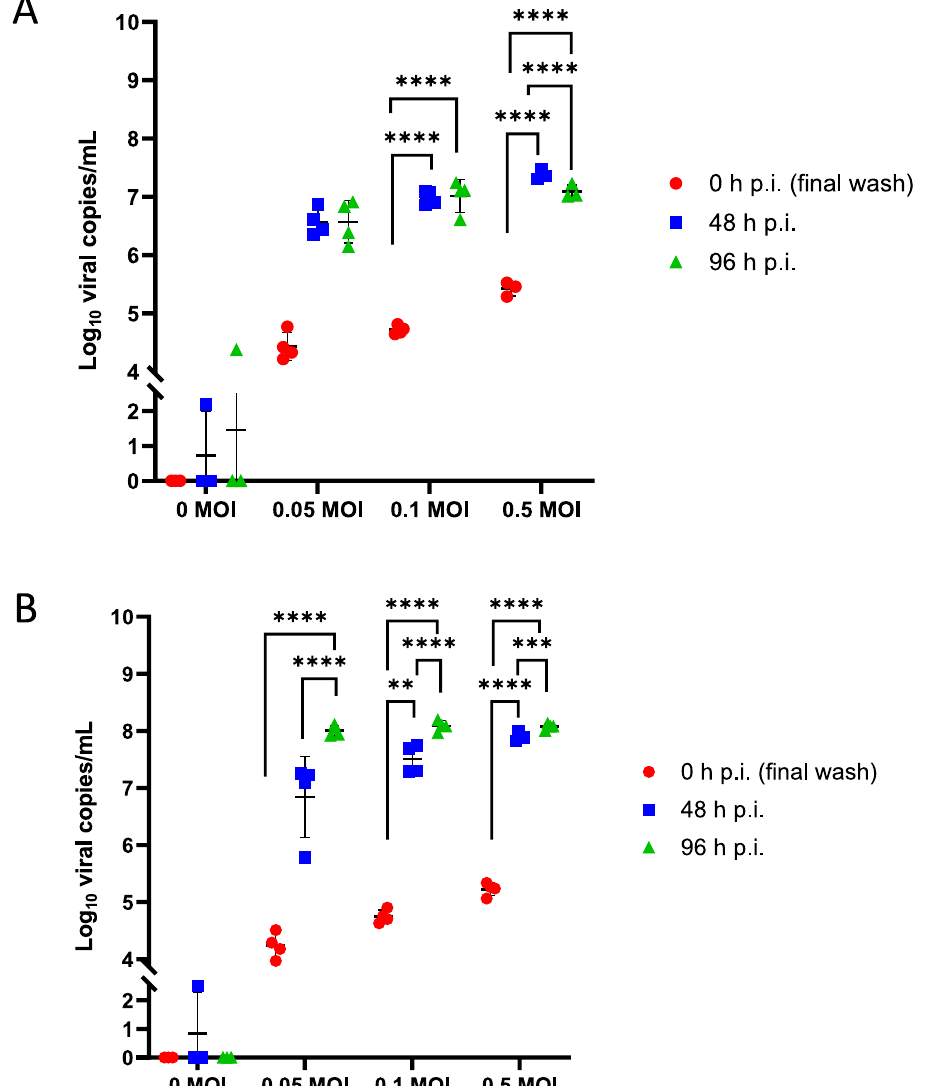
Figure 8. Infection kinetics of HCoV-NL63-inoculated PREDICT96-ALI airway tissue. RT-qPCR analyses for viral copies in the apical wash of PREDICT96-ALI airway tissue at 0, 48 and 96 h p.i. for two human donors showing unique infection kinetic profiles. ( A ) PREDICT96-ALI donor A airway tissue inoculated with HCoV-NL63 and monitored for an increase in viral load at 48 h intervals with a statistically significant increase in viral copies at 48 and 96 h p.i compared to 0 h p.i. for the MOI 0.1 and 0.5 conditions. Statistical significance: ****p ≤ 0.0001. ( B ) PREDICT96-ALI donor B airway tissue inoculated with HCoV-NL63 and monitored for an increase in viral load at 48 h intervals with a statistically significant increase in viral copies at 96 h p.i compared to 48 and 0 h p.i. for MOI 0.05, 0.1, and 0.5, as well as a statistically significant increase in viral copies at 48 h p.i. compared to 0 h p.i. for MOI 0.1 and 0.5 conditions. Transient, non-productive viral infection detected at 48 h p.i. in mock condition (0 MOI), is likely the result of technical handling by the experimental operator. Statistical significance: **p ≤ 0.01, ***p ≤ 0.001, and ****p ≤ 0.0001. N = 2 independent experiments with data presented from one representative experiment. Per experiment, N = 3–4 tissue replicates per donor, time-point and condition. Replicates that did not meet the minimum signal intensity after 45 PCR cycles are displayed along the